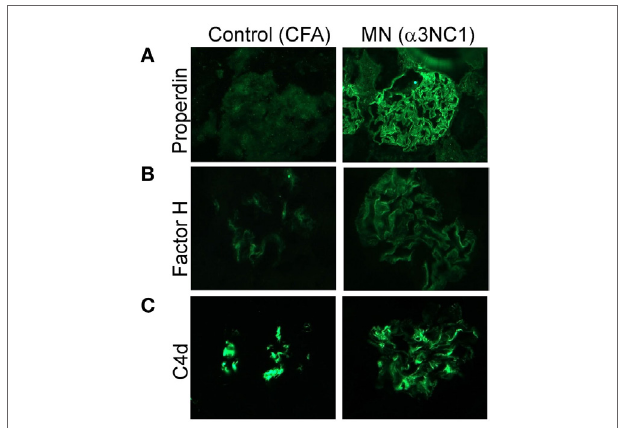
FigUre 3 | Histologic evidence of AP activation in experimental MN. Glomerular deposition of properdin (a) , factor H (B) , and C4d (c) was evaluated by indirect immunofluorescence staining of frozen kidney sections from α 3NC1-immunized D1 mice and adjuvant-immunized control mice. Properdin and factor H staining along the capillary loops was found in α 3NC1-immunized D1 mice, but not in adjuvant-immunized mice. Mesangial C4d staining was found in all mice, while weaker segmental staining for C4d along capillary loops was also present in α 3NC1-immunized mice.